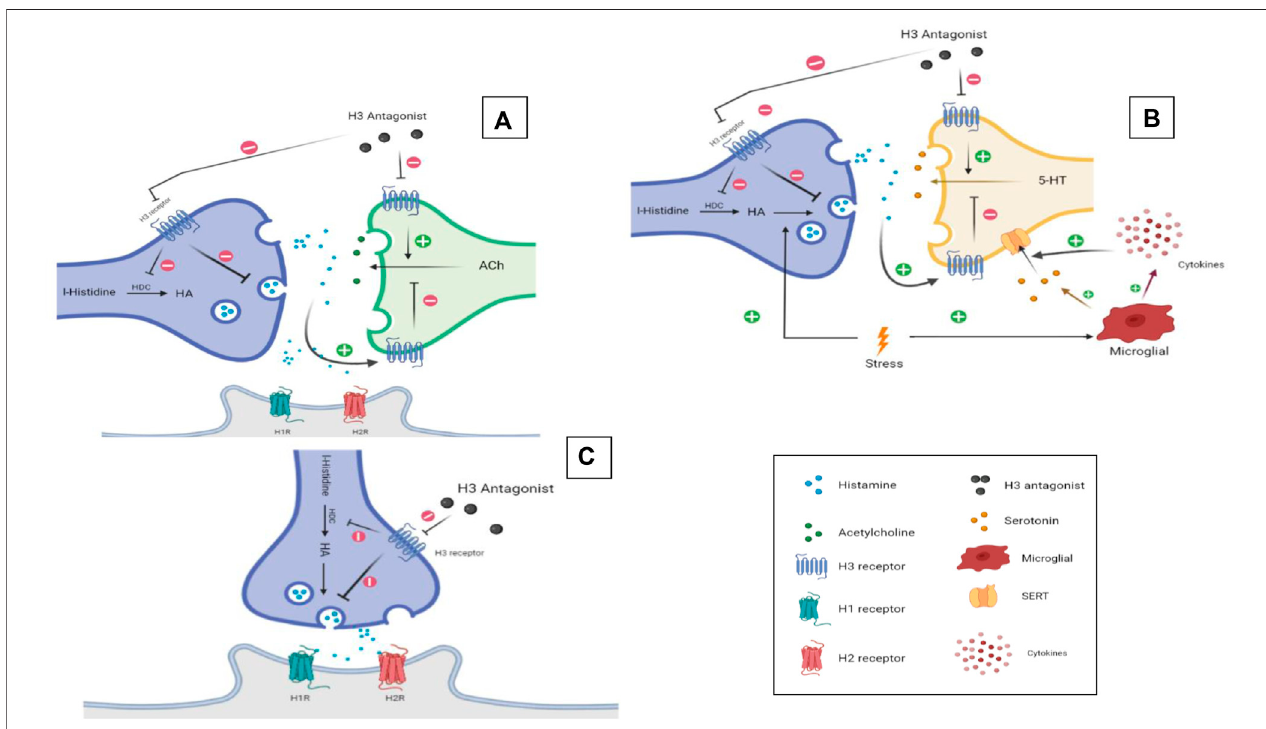
FIGURE 2 | H3R antagonists/inverse agonists. Putative mechanisms underlying memory enhancement effect (A) , antidepressant (B) , and sleep – wake cycle regulation (C) of H3R antagonists/inverse agonists. Graphics were constructed using BioRender software and were licensed for publication.